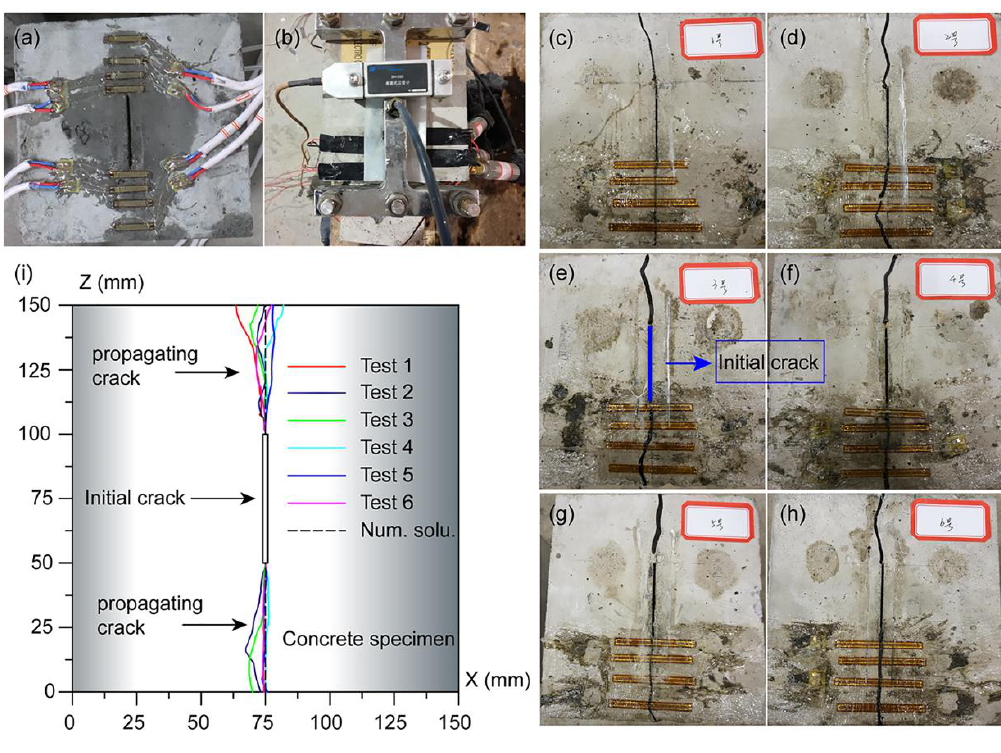
Figure 12. The test process (see a , b ) and chart of the fracture propagation path containing both the test results (see c – h ) and the numerical results ( i ).